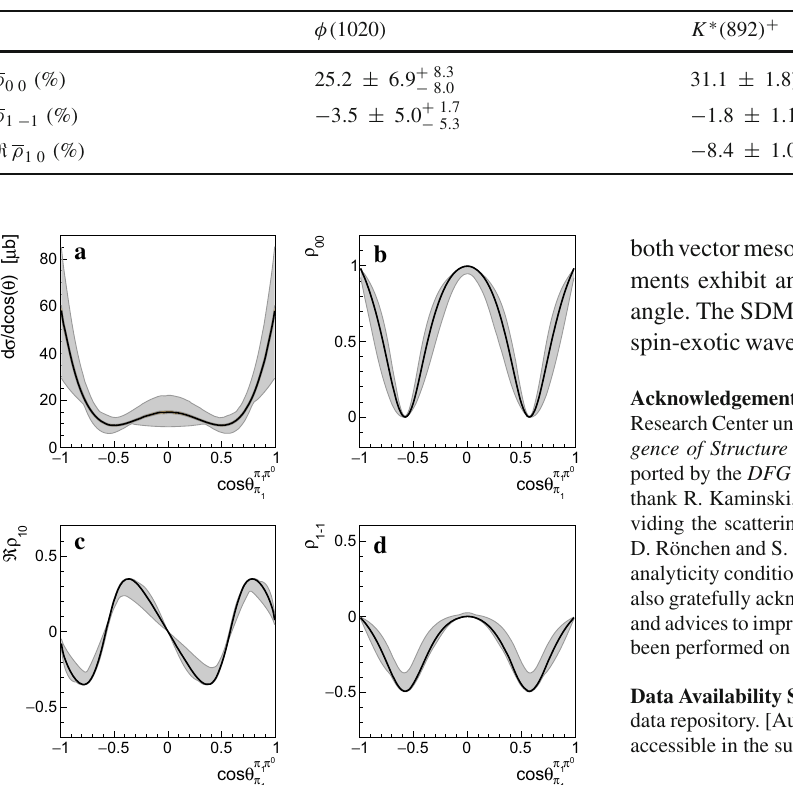
Table 5 Spin density matrix elements averaged over the whole produc- tion cross section for the φ( 1020 ) , K ∗ ( 892 ) + and π 0 their respective helicity system. The errors give the statistical and the